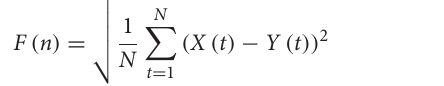
Frontiers in Neurology |